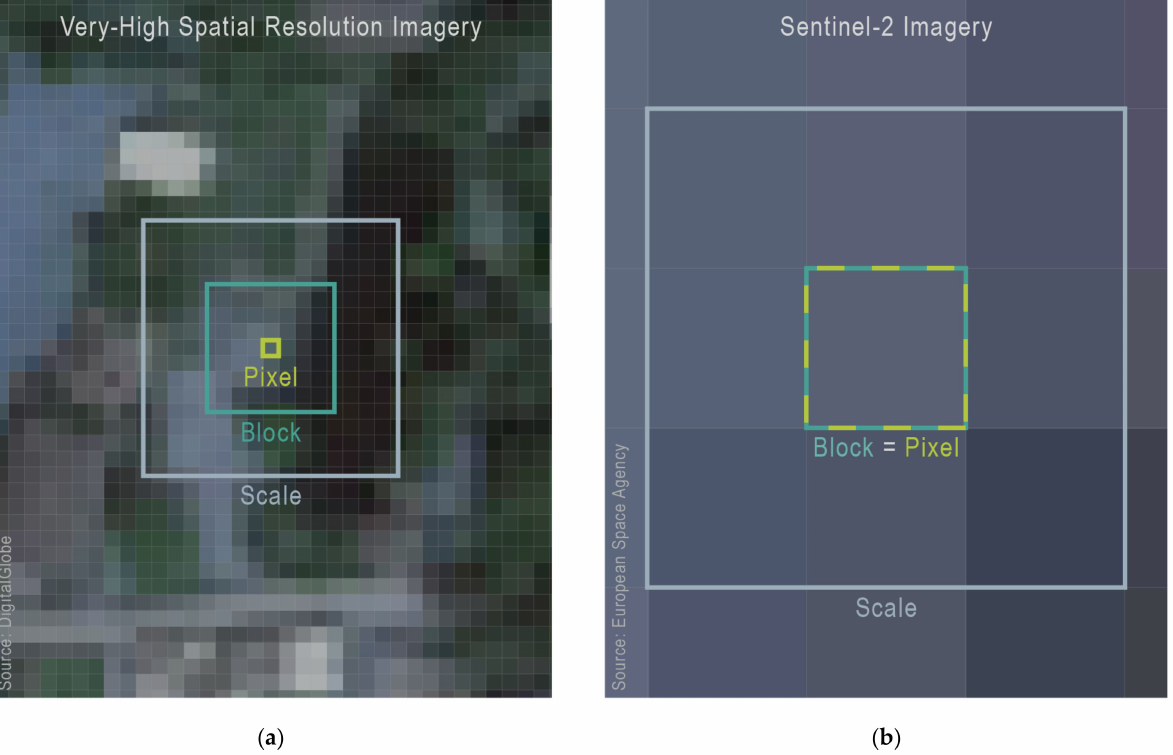
Figure 3. Scale and block for calculating contextual features. For very-high-spatial-resolution imagery ( a ), the scale sizes were set to 8 m × 8 m, 16 m × 16 m, 32 m × 32 m, and 64 m × 64 m, and the block size was set to 8 pixels. For Sentinel-2 imagery ( b ), most scale sizes were set to 30 m × 30 m, 50 m × 50 m, and 70 m × 70 m, and the block size was set to one pixel. Sources: